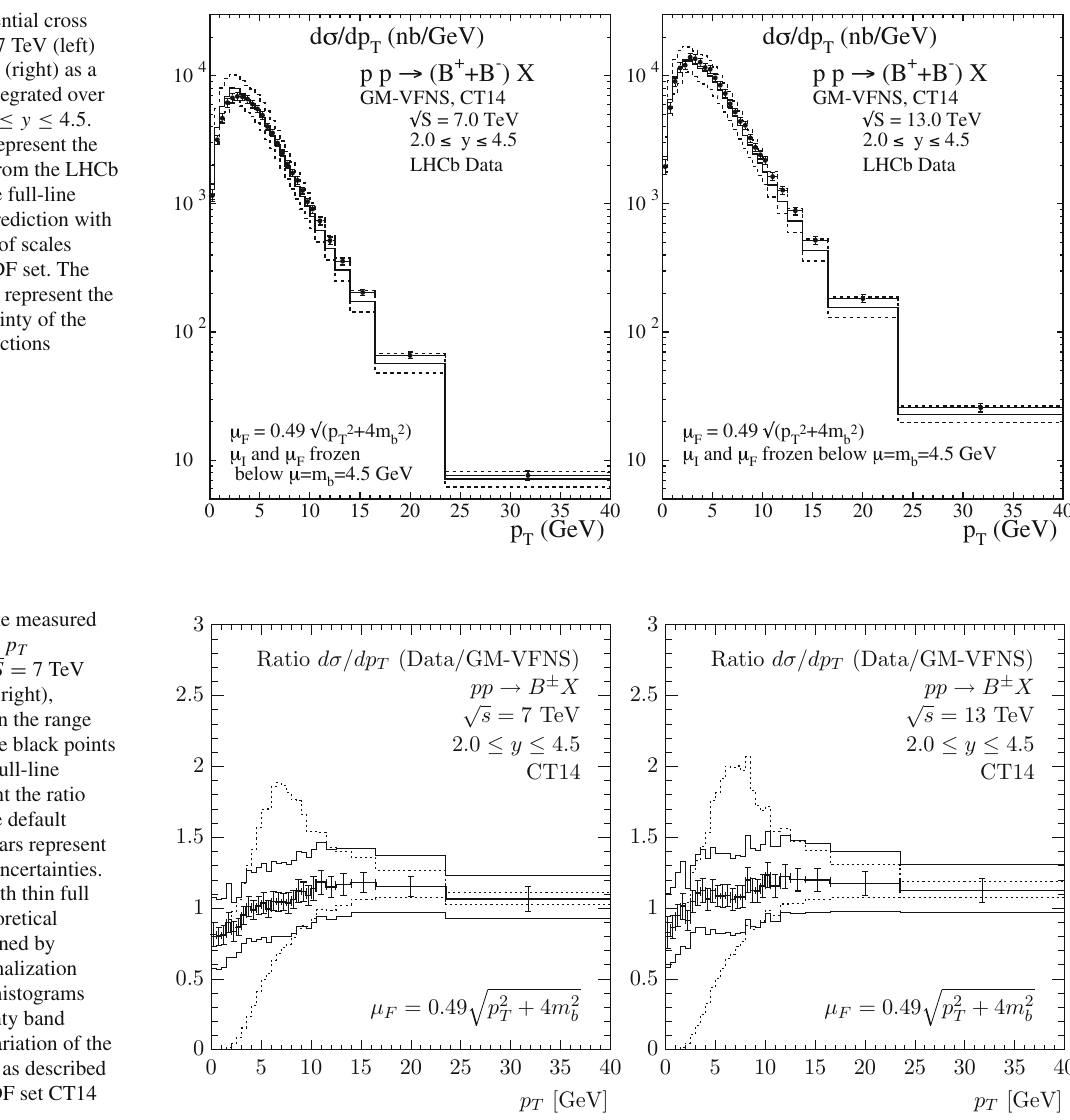
+ 4 m 2 μ F = 0 . 49 p 2 T p T [GeV]